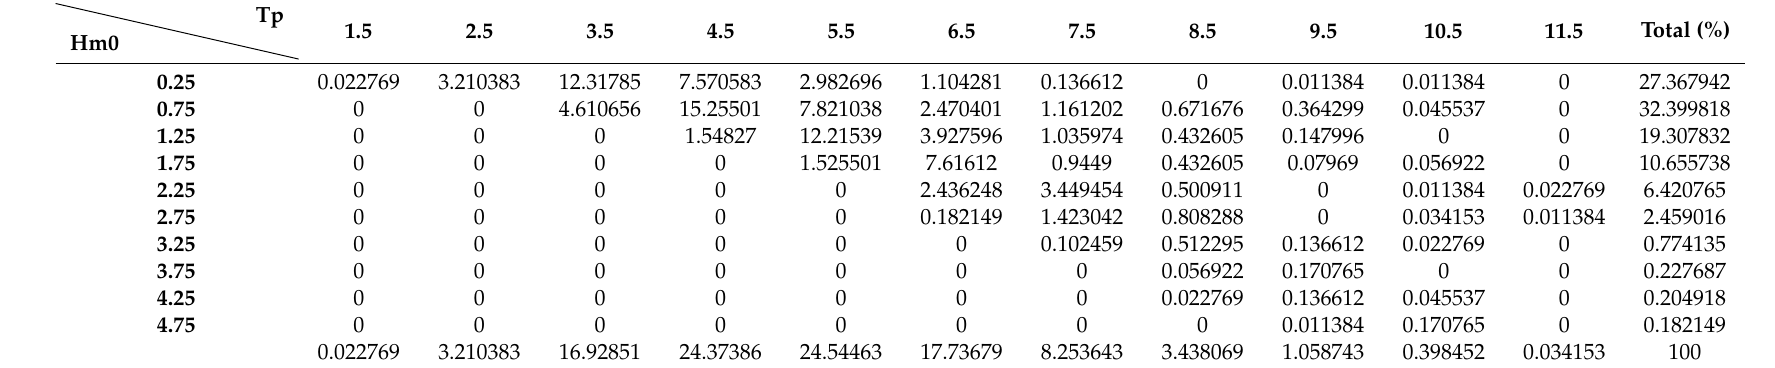
Table 1. Probability of occurrence (%) for different wave conditions.